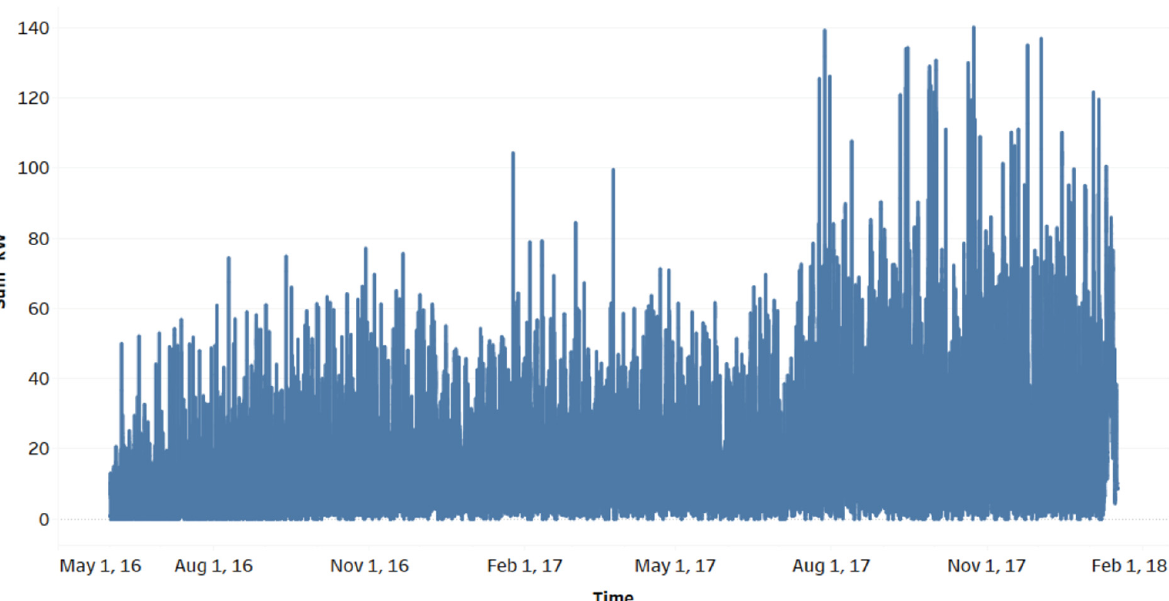
Figure 4. Total charging power consumed by 65 EVs during a US trial held from May 2016 to February 2018. The impact of 6 EVs with higher battery capacity and charging rate, added into the trial in July 2017, is very evident. (Reprinted with permission from Ref. [57]. Copyright 2018 EPRI.)